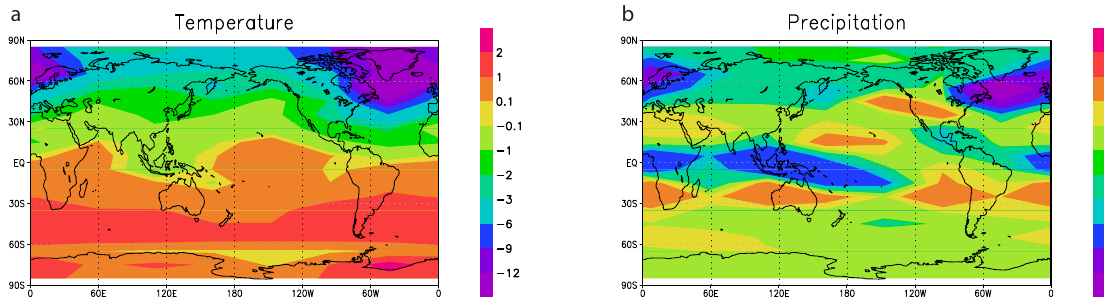
Fig. 11. Air temperature ( ◦ C) and precipitation (mmyr − 1 ) anomalies between the collapse state of the AMOC compared to the control state (years1390–1400 minus years990–1000). The simulation considered is during the LGM with a fresh water flux added into the North Atlantic of 0.5Sv during 400